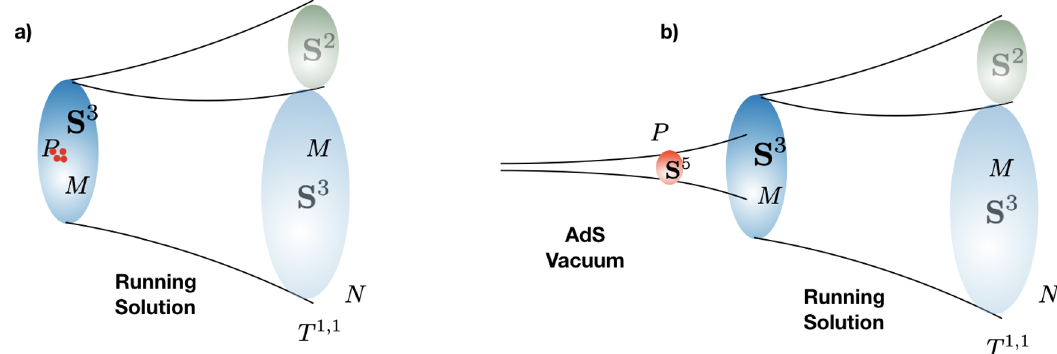
Figure 1 . Domain wall interpolating between the conifold theory with fractional branes, and an AdS vacuum. Figure a) shows a heuristic intermediate step of a KS solution with a number P of left- over probe D3-branes. If P is large, the appropriate description requires including the backreaction of the D3-branes, which lead to a further AdS throat, to the left of the picture in figure b). Hence the running of the dynamical tadpole in the right hand side ends in a domain wall separating it from an AdS vacuum.